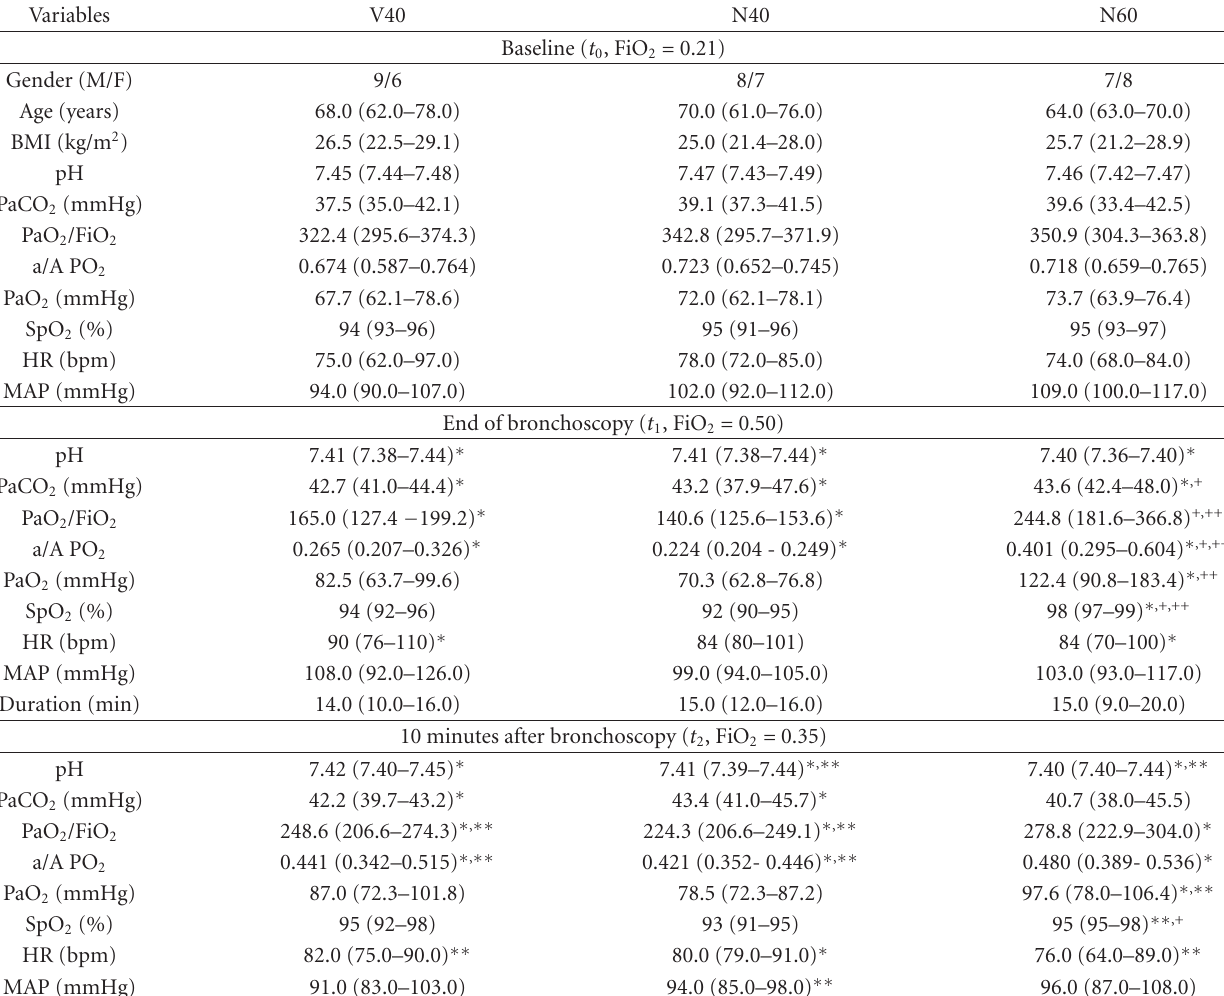
Table 1: Anthropometric, respiratory, and cardiovascular data under facial and di ff erent nasal interfaces.